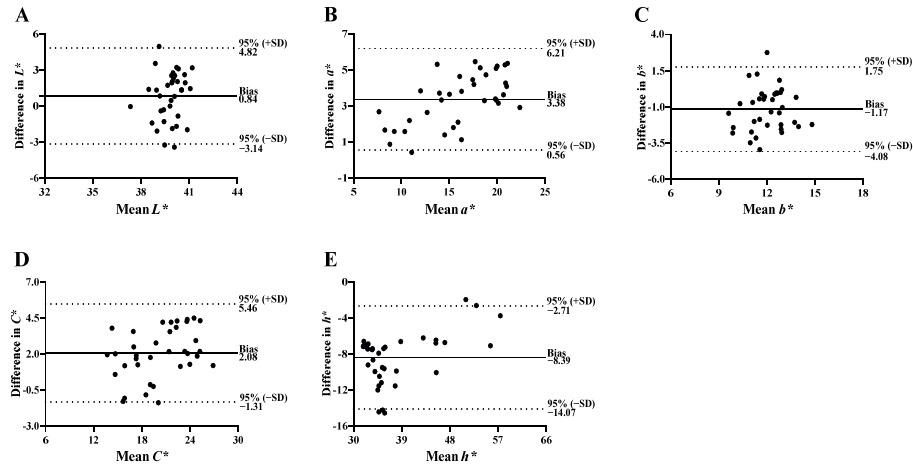
Figure 5. Bland-Altman limits of agreement of lightness ( L *; ( A )), redness ( a *; ( B )), yellowness ( b *; ( C )), chroma ( C *; ( D )), and hue ( h *; ( E )) values obtained from beef steaks using Spectro 1 and MiniScan. The bias for L * was 0.84, with 95% limits of agreement ranging from − 3.14 to